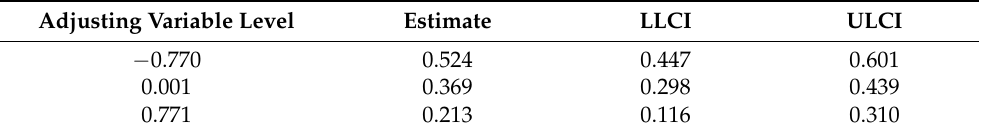
Table 7. Test results from moderated